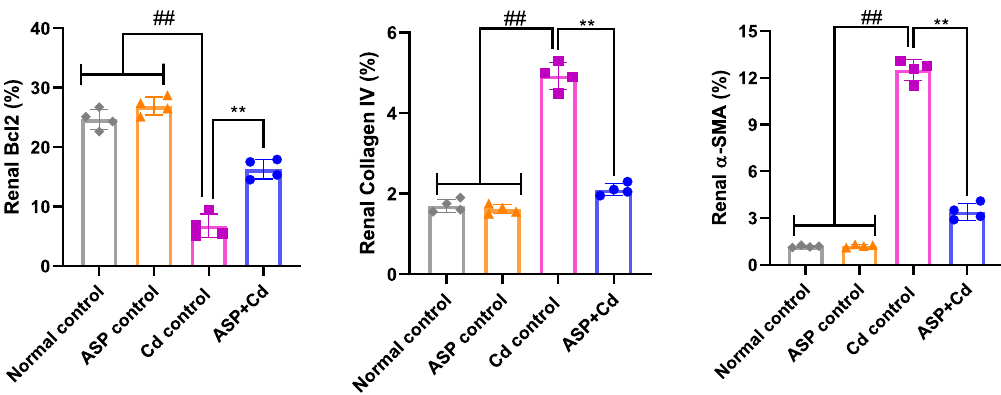
Figure 6. Immunohistochemical staining of ( A ) Bcl2, collagen IV and α-SMA, ( B ) quantitative levels of Bcl2, collagen IV and α-SMA in the kidney tissues of cadmium administered rats. Immunohistochemical staining of ( C ) Bcl2, collagen IV and α-SMA, ( D ) quantitative levels of Bcl2, collagen IV and α-SMA in the heart tissues of cadmium administered rats Data were presented as the mean ± SD (n = 4). ## p < 0.05 compared to normal and ASP control groups; ** p < 0.05 compared to Cd control